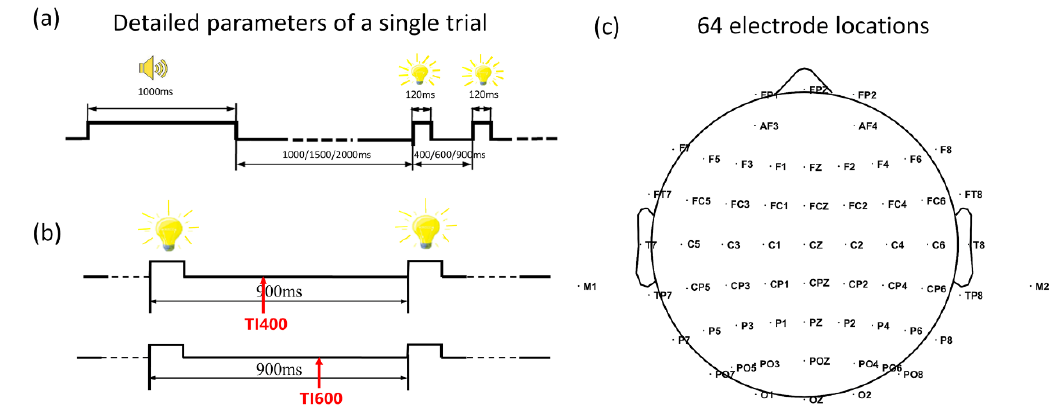
Figure 1. ( a ) Detailed parameters of a single trial. ( b ) Expected moment in a single trial. ( c ) 64 electrode